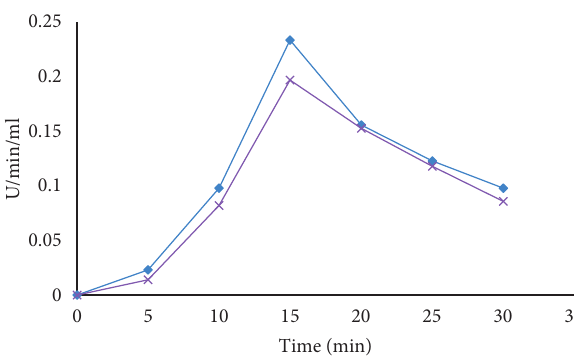
Figure 4: Effect of time reaction of B. licheniformis (blue) and B. cereus (purple) for amylase production.